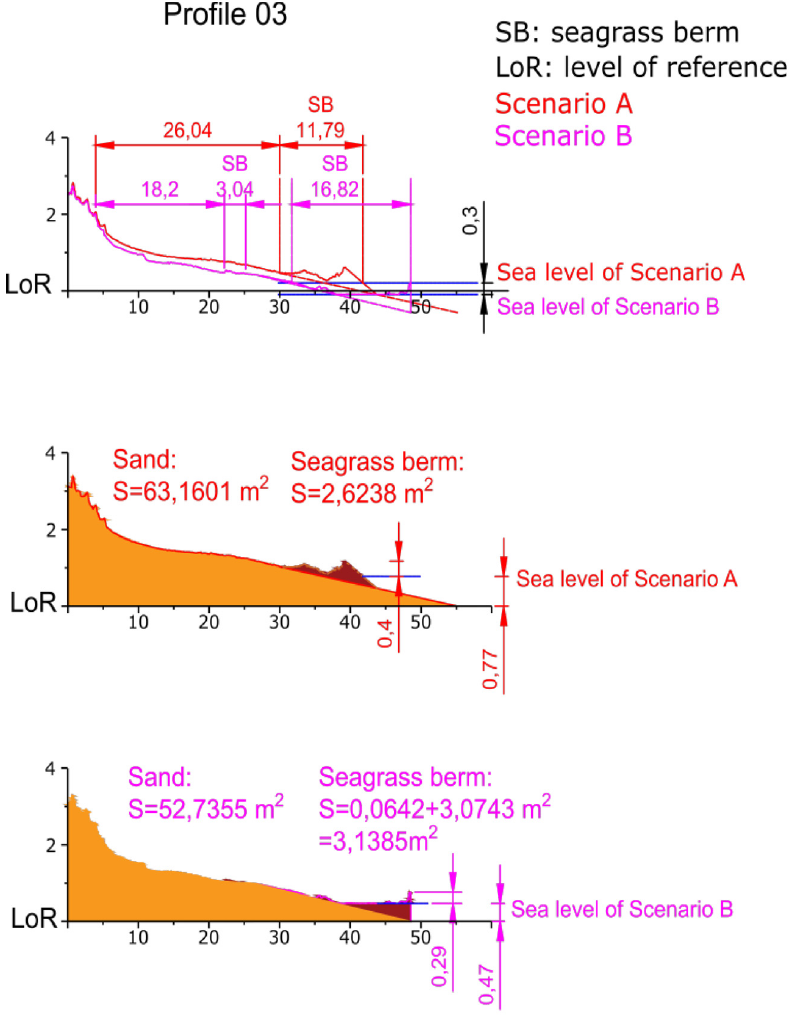
Figure 8. Extraction of areas for profile 3. Front berm height, seagrass berm width, and distance to the stable area are shown.